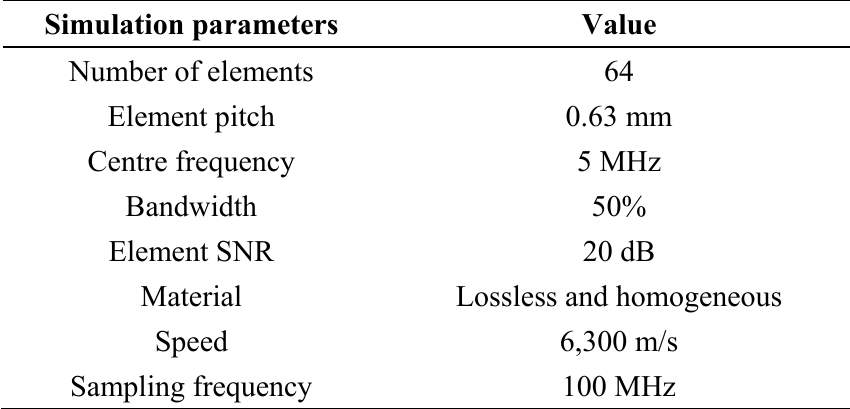
Table 1. Simulation